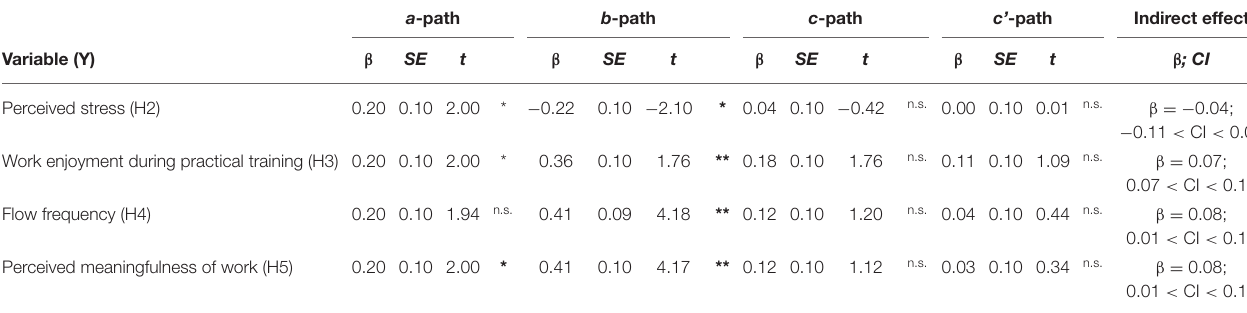
TABLE 6 | Mediation models of the effect of the humor intervention (X) via sense of humor (M) on the dependent variable (Y). a -path b -path c -path c’ -path Indirect